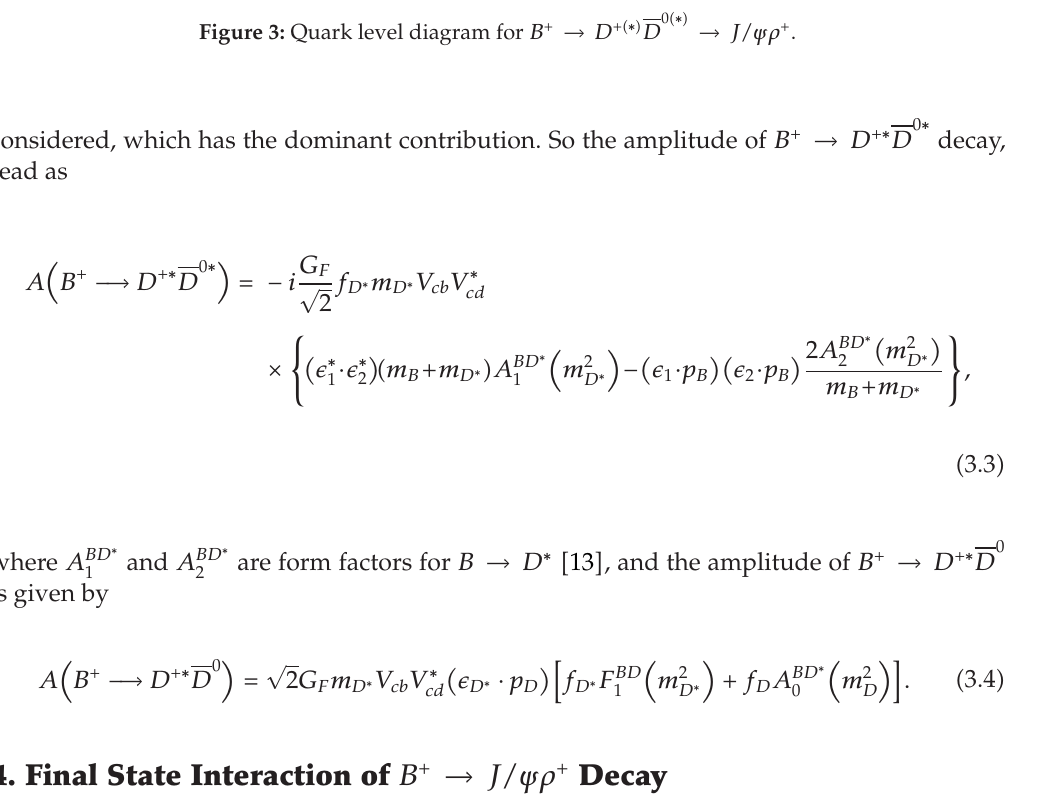
0 (cid:3) ∗ (cid:4) → J/ψρ (cid:2)